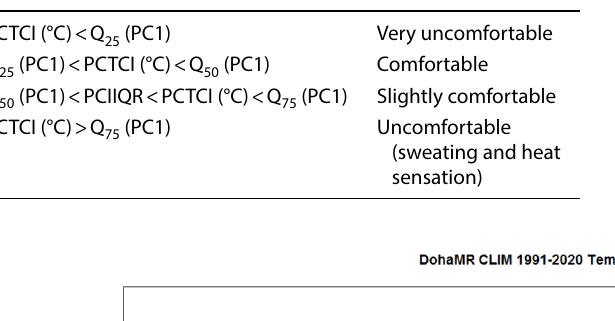
Table 7 Alternative PCTCI cognitive thresholds